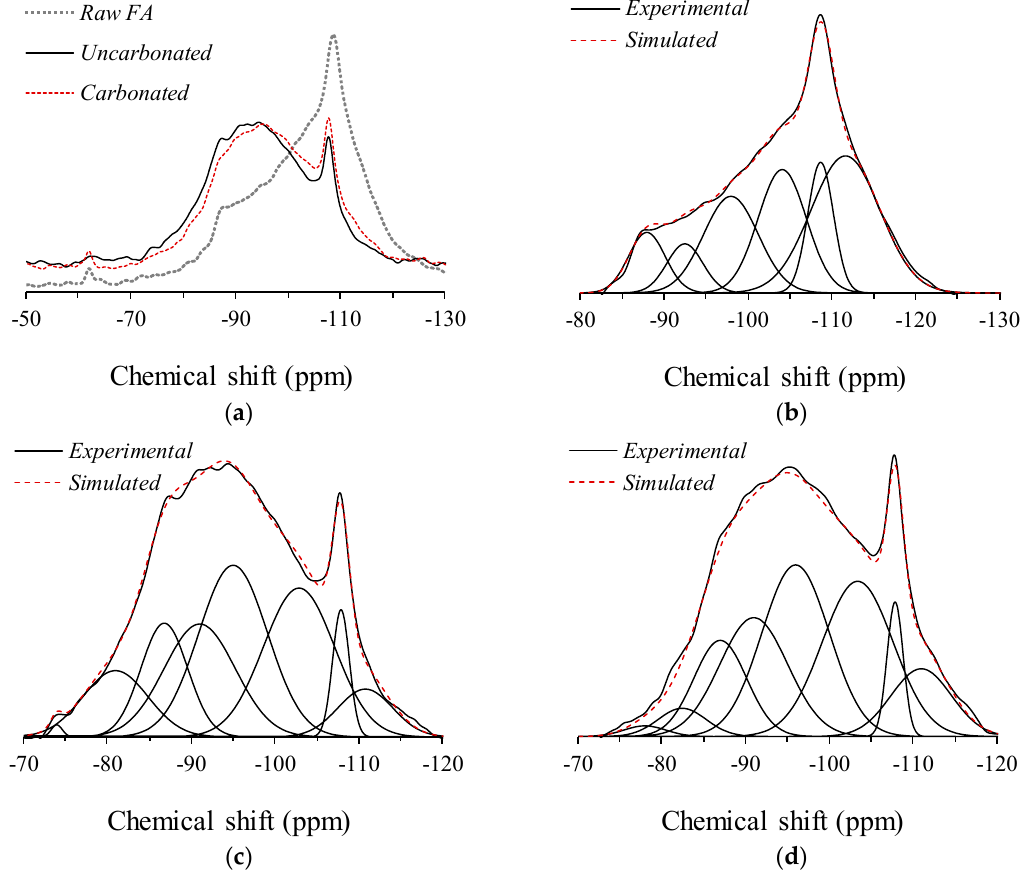
Figure 1. 29 Si MAS NMR spectra of ( a ) all; ( b ) raw fly ash; and ( c ) uncarbonated and ( d ) carbonated alkali-activated fly ash.